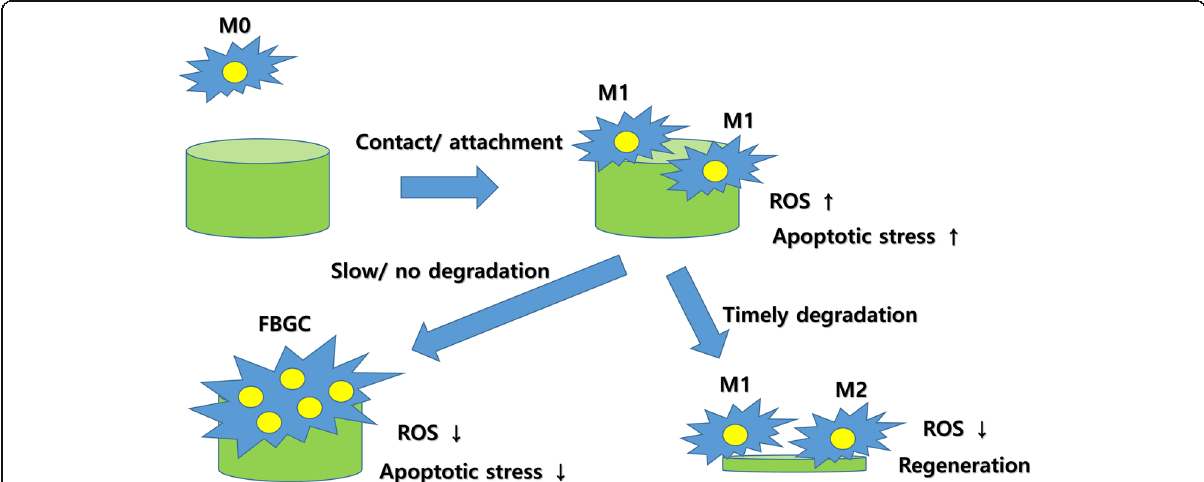
Fig. 4 Hypothesis for M1/M2/foreign body giant cell (FBGC) formation. Cellular stress induced by a foreign body may be the driving force for macrophage differentiation. Reactive oxygen species (ROS) may also be a key factor for macrophage differentiation. Slow or nondegradable grafts accumulate stress in the macrophages. To reduce intracellular stress, increasing the volume of cytoplasm via cellular fusion can be a useful strategy for survival. If the graft is degraded appropriately, intracellular stress is reduced thereafter. M2 transition will occur after reduced stress